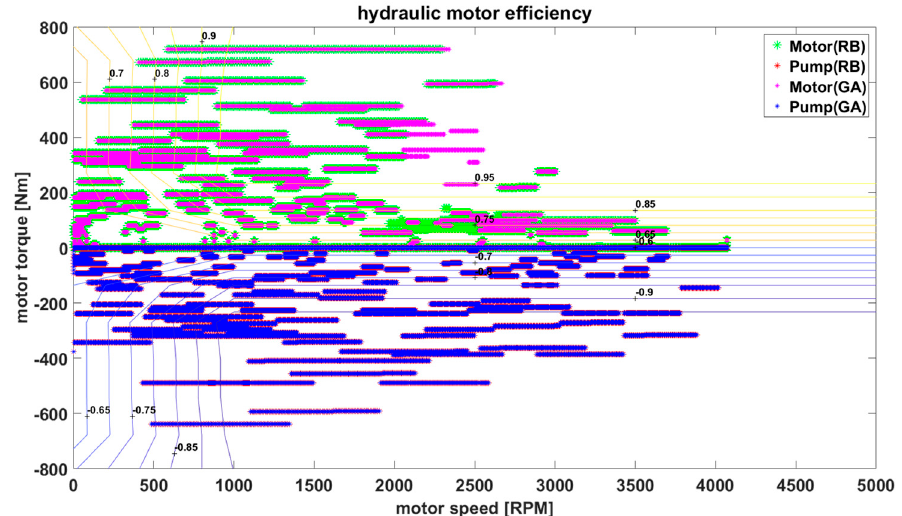
Figure 16. Comparison of operating-point distribution of hydraulic motor/pump (GA vs. rule-based).